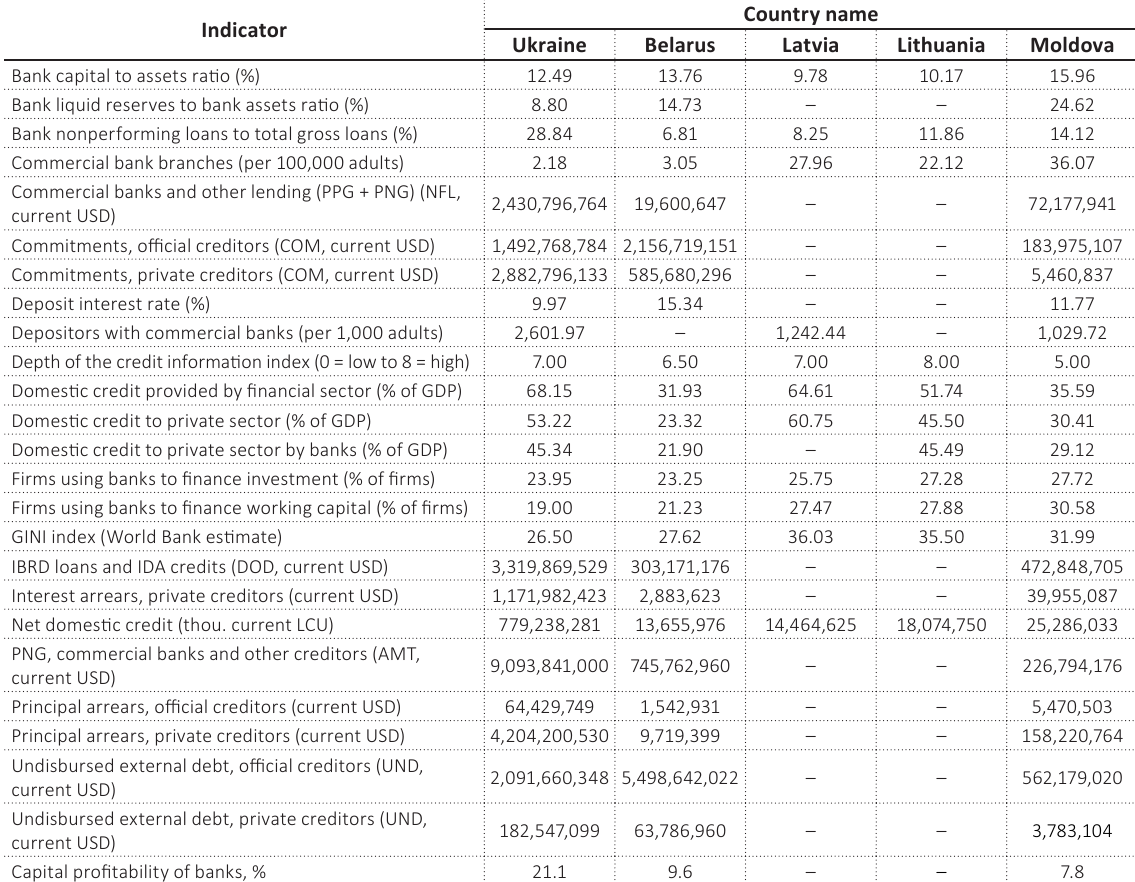
Table 1. Average value of bank performance in some Eastern European countries on average for the period 2010–2019